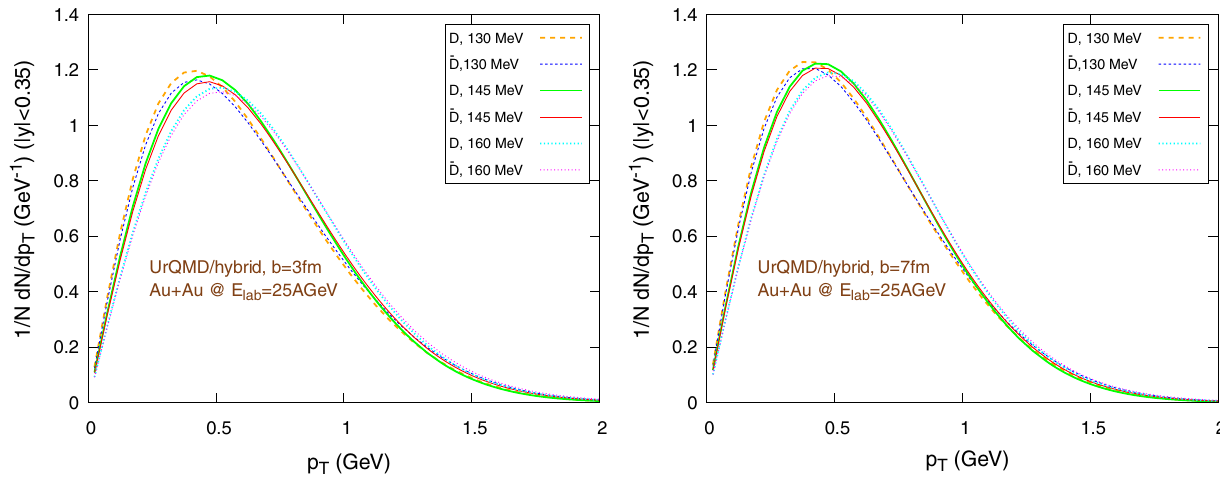
Fig. 10 Normalized 1 / N d N / d p T distribution of the final D / ¯ D mesons, in the rapidity range | y | < 0 . 35, for Au+Au collisions at E lab = 25AGeV, using the UrQMD/hybrid model. The hadronization parameters are (cid:23) p = 0 . 05 and